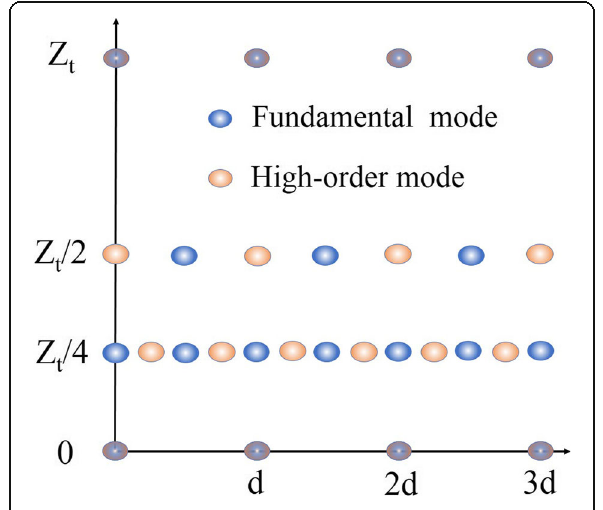
Fig. 1 Fundamental and high-order supermode distribution at fractional Talbot planes. Blue ovals correspond to fundamental supermodes, and brown ovals correspond to high-order supermodes